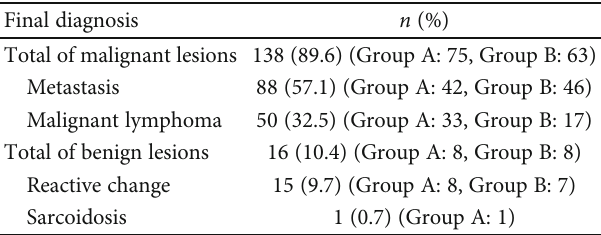
Table 2: Final lymphadenopathy diagnoses ( n = 154 ). Final diagnosis n